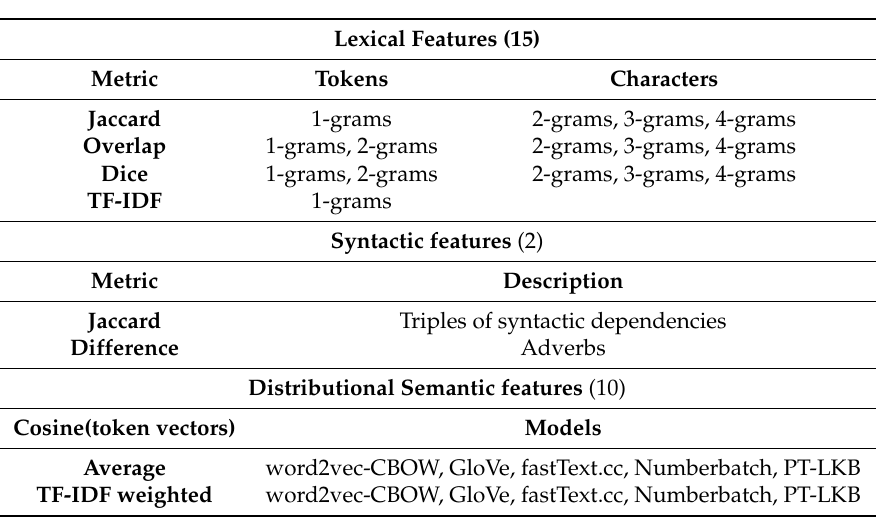
Table 7. Features in the reduced